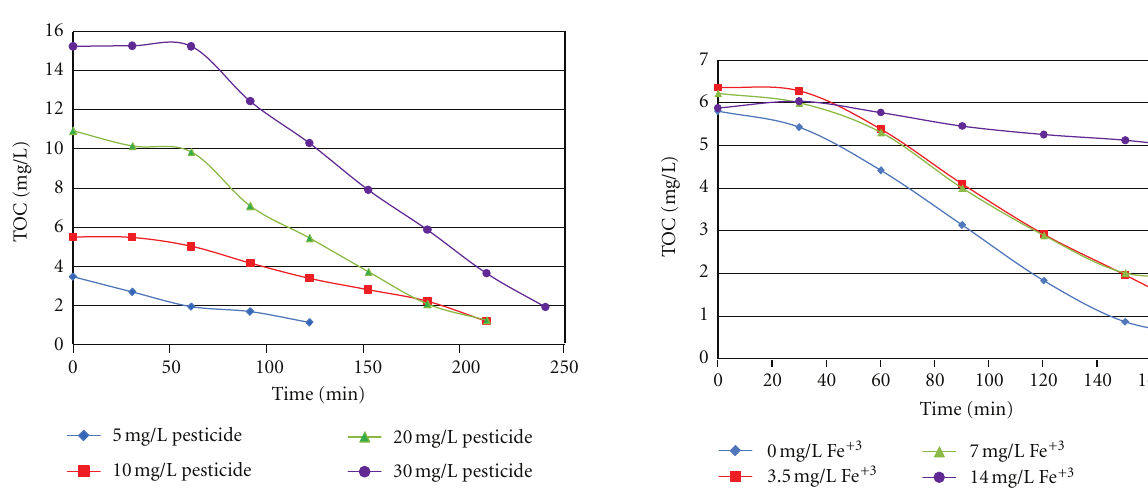
Figure 5: Pesticide degradation over time at di ff erent pH values of the initial solution (initial conditions: 10ppm mepiquat chloride, 0.5g/L TiO 2 P-25, UV-A lamp).